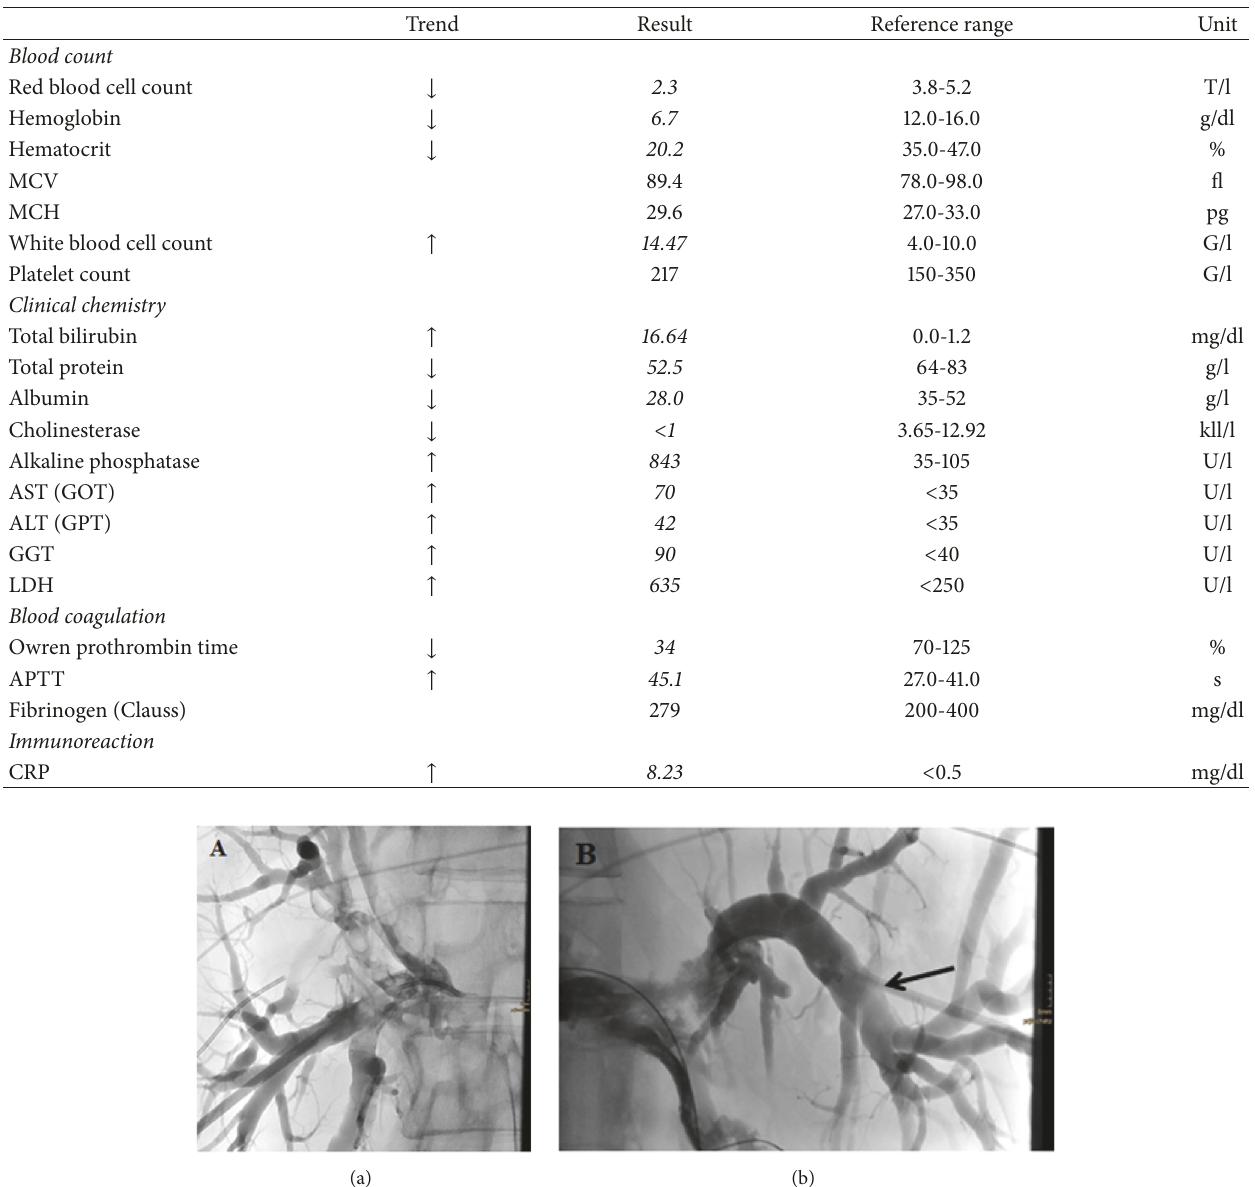
Figure 2: Percutaneous transhepatic biliary drainage (PTBD): consecutive puncture of the right and left biliary ducts, separated by the tumor; catheter in the dilated left biliary ducts (arrow). (a) right (b) left side.